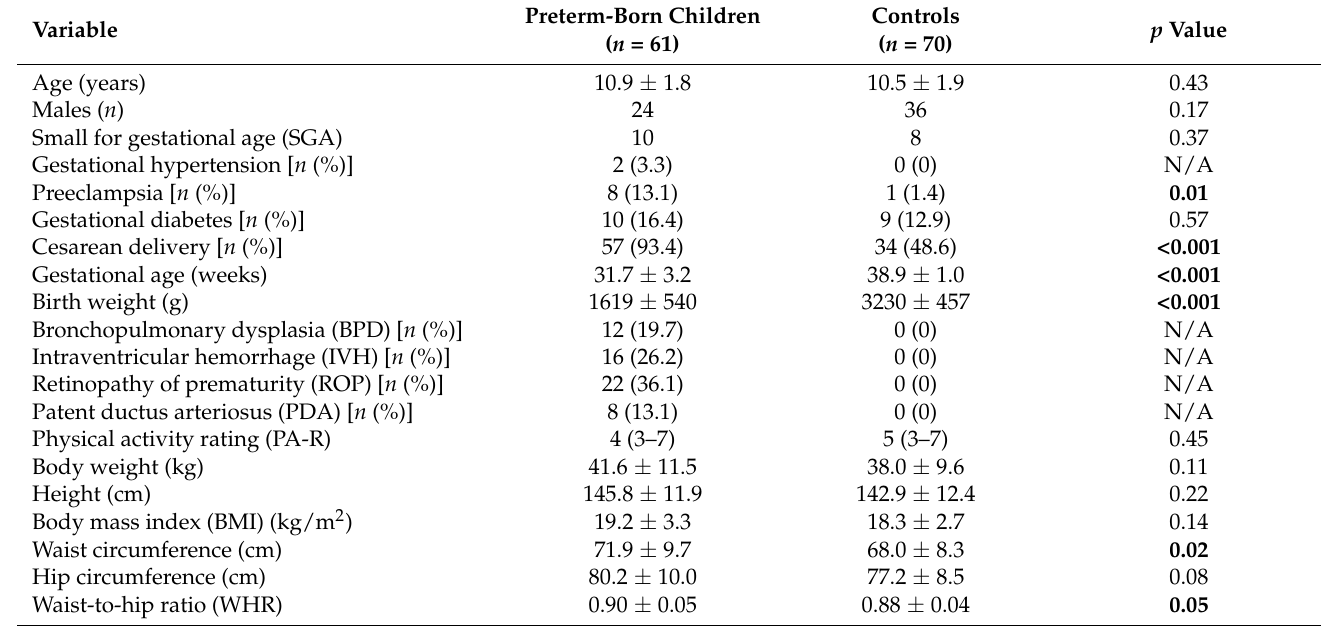
Table 1. Clinical, neonatal and perinatal characteristics, and biochemical profile of study